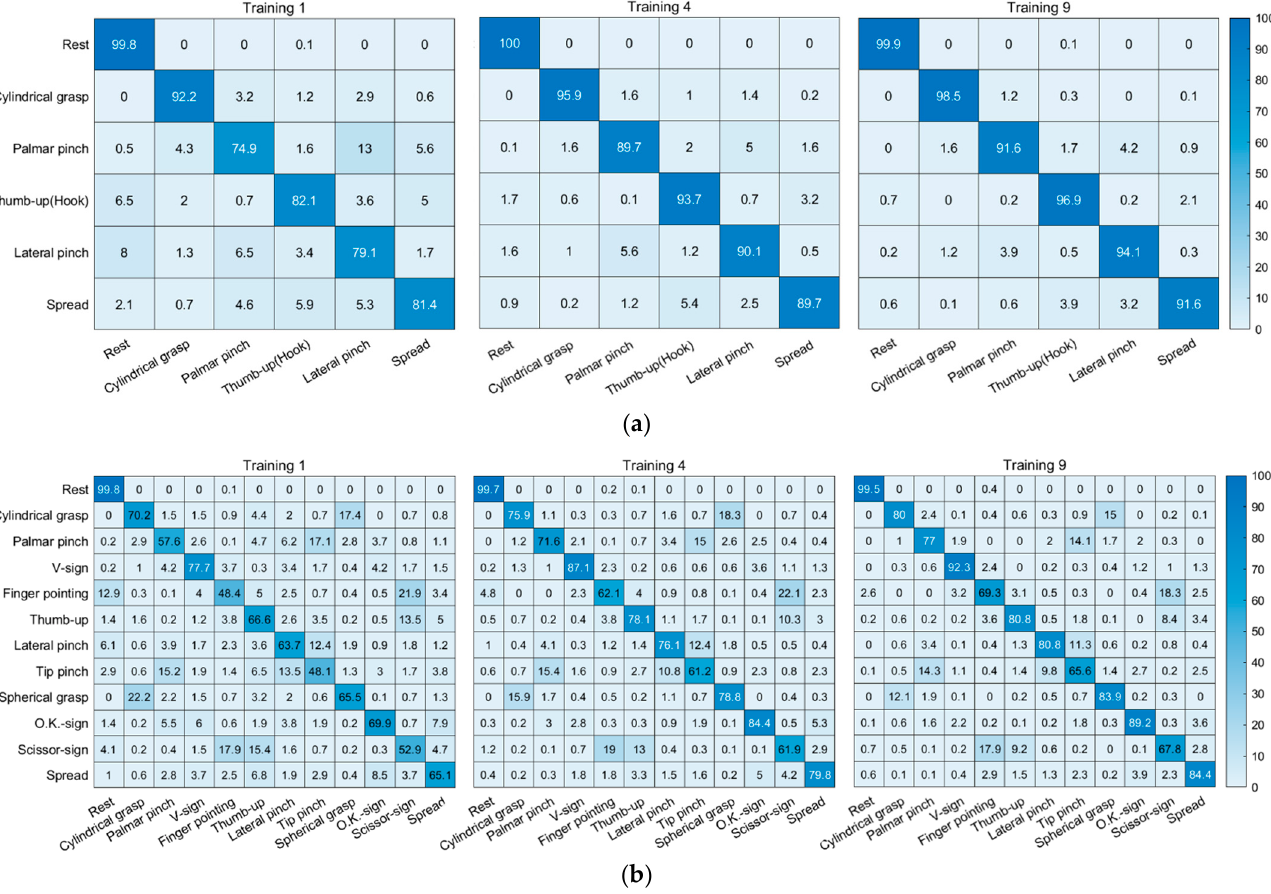
Figure 7. Confusion matrices of the hand postures: ( a ) Group 1 and ( b ) Group 7.